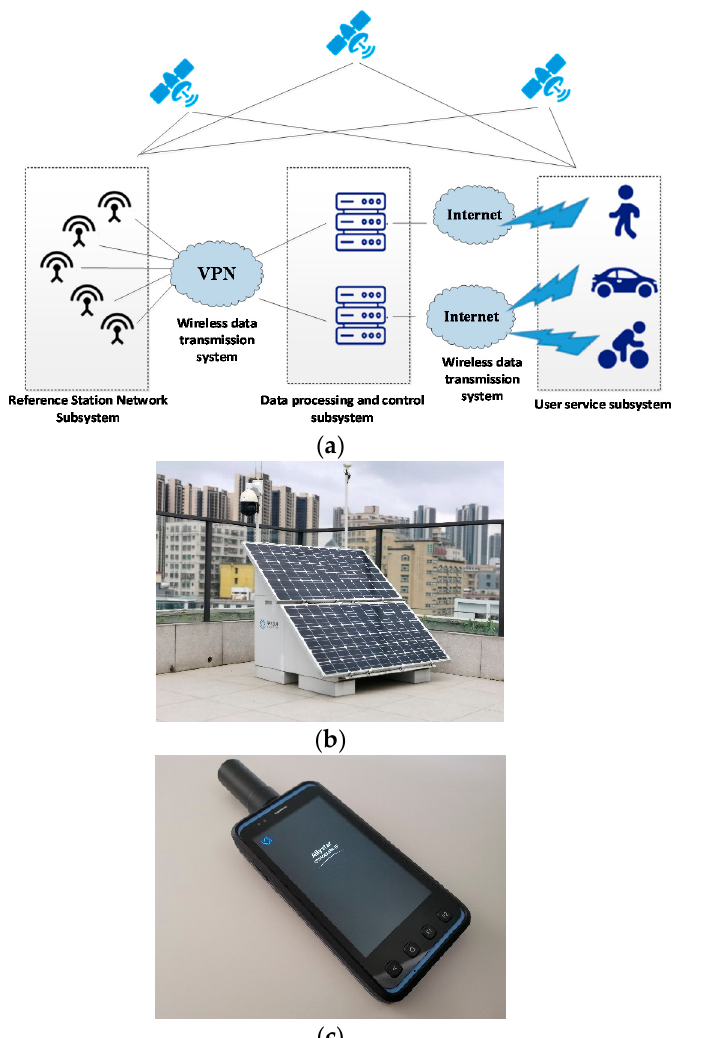
Figure 10. Evaluation of RTK systems based on cellular networks. ( a ) RTK network architecture diagram based on cellular network; ( b ) Photo of a reference station; ( c ) Photo of user device.